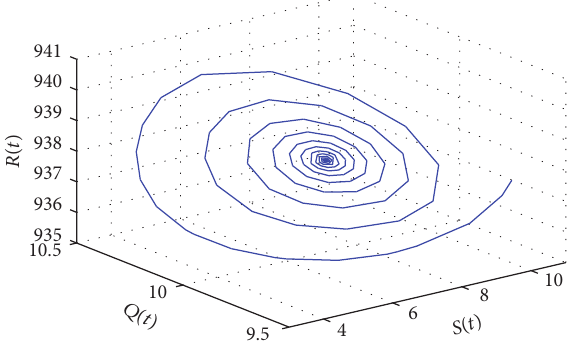
Figure 21: The phase plot of 𝑆 , 𝑄 , and 𝑅 when 𝜏 2 = 1.235 < 1.3485 = 𝜏 󸀠 20 and 𝜏 1 = 0.65